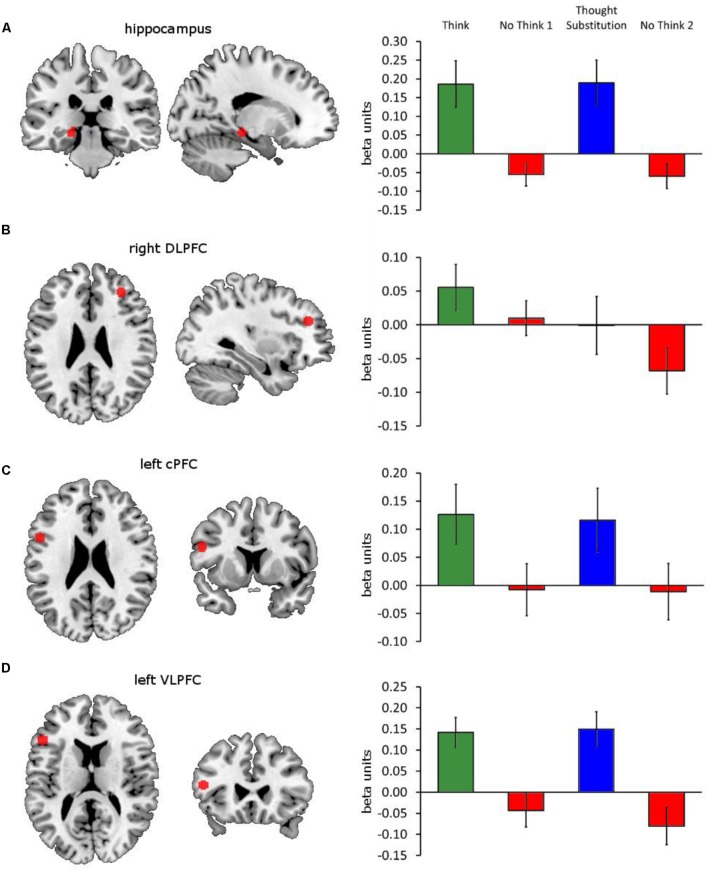
Four ROIs and their beta amplitude responses. Illustrations of the ROIs in red (left) and their beta amplitude responses to think, memory substitution, no-think1 and no-think2 (right) are shown for (A) left hippocampus, derived from a cluster within the think vs. threshold contrast thresholded at p < 0.0001, and 5 mm radius spheres centered on (B) right DLPFC [32, 38, 26], (C) left caudal PFC (cPFC) [-52, 9, 24] and (D) left VLPFC [-50, 25, 14] (BA 45). Error bars represent ±1 SEM.